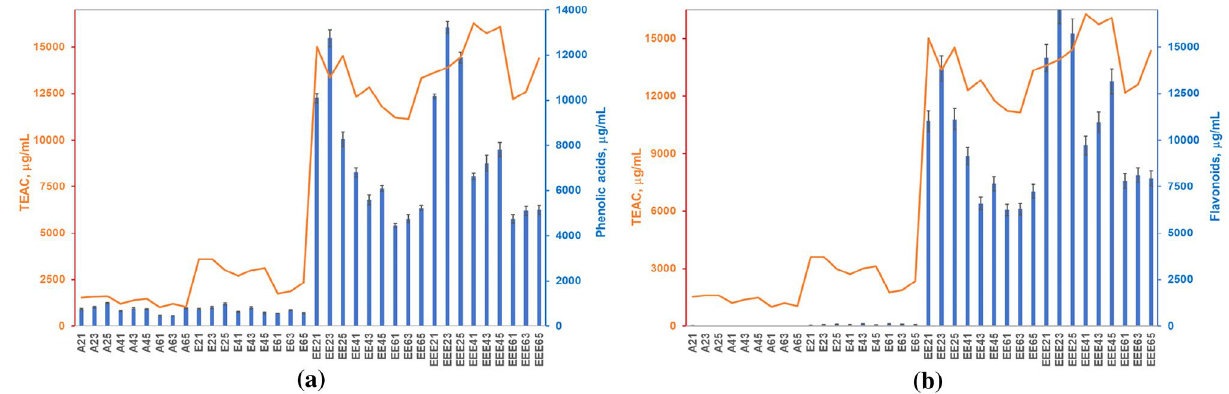
Figure 3. Antioxidant effects variation (ABTS assay) with phenolic acids ( a ) and flavonoids ( b ) distribution.